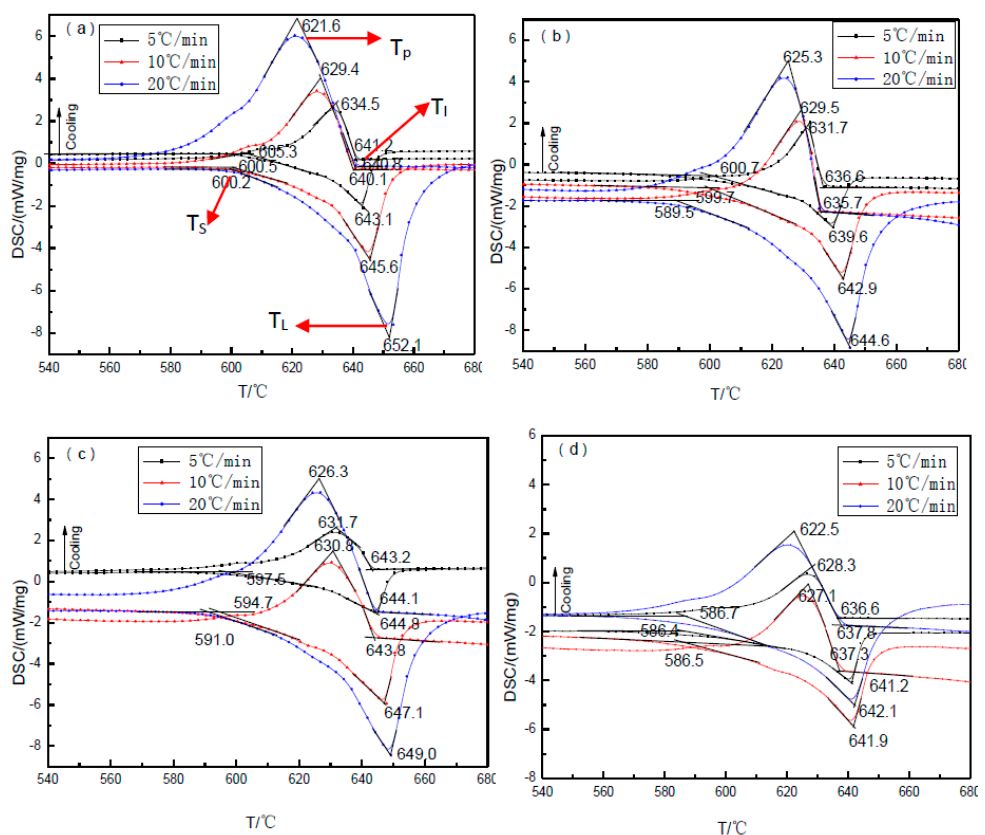
Figure 5. The differential scanning calorimetry (DSC) pattern of TiB 2 /7075 composites with different heating and cooling rates between 400 °C and 700 °C. ( a ) 3.0% TiB 2 /7075; ( b ) 4.5% TiB 2 /7075; ( c ) 6.0% TiB 2 /7075; ( d ) 9.0% TiB 2 /7075 .